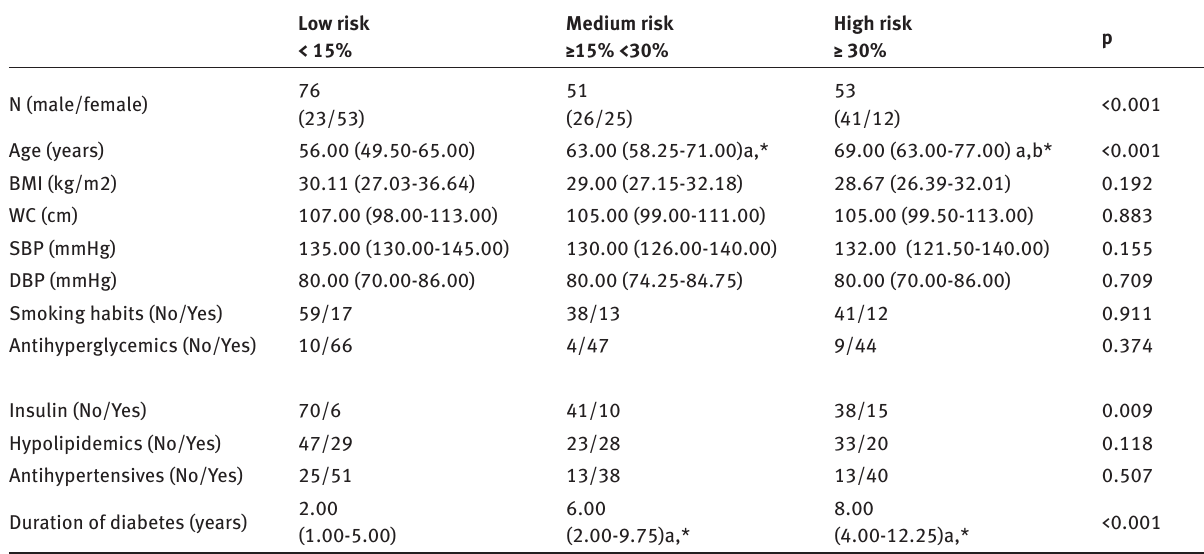
Table 1: Demographic characteristics of diabetic patients according to CVD